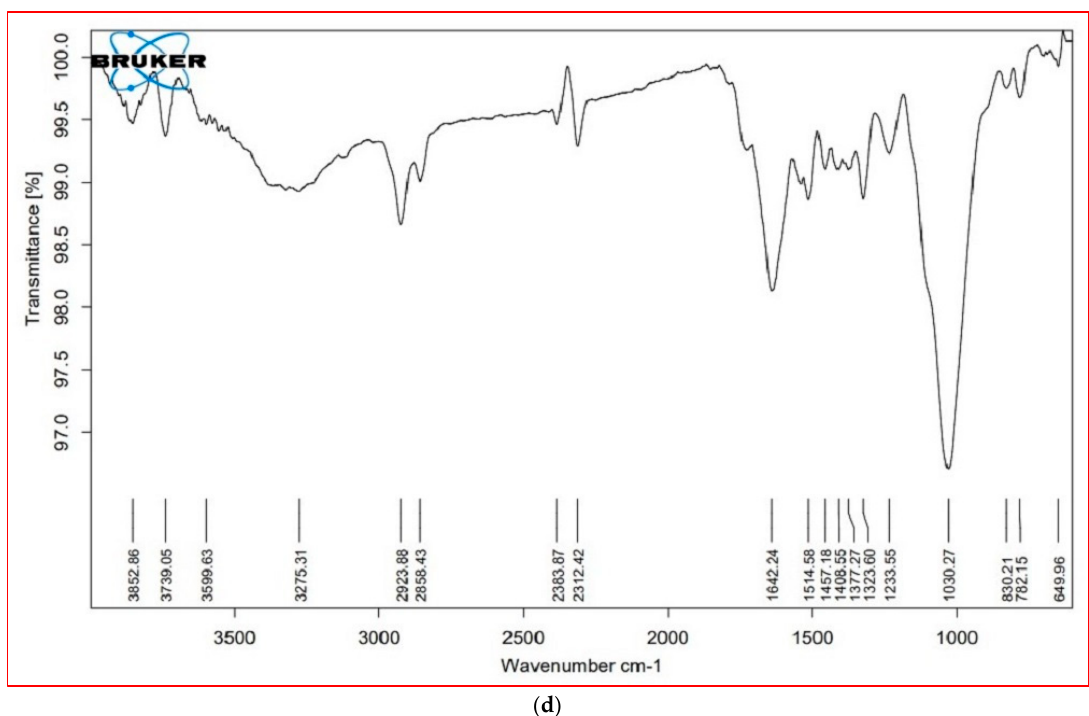
Figure 5. FTIR profiles of different tissue of the plants, 5a= S. nudiflora leaves, 5b= S. nudiflora stem, 5c= S. fruticosa leaves, 5d= S. fruticosa stem.